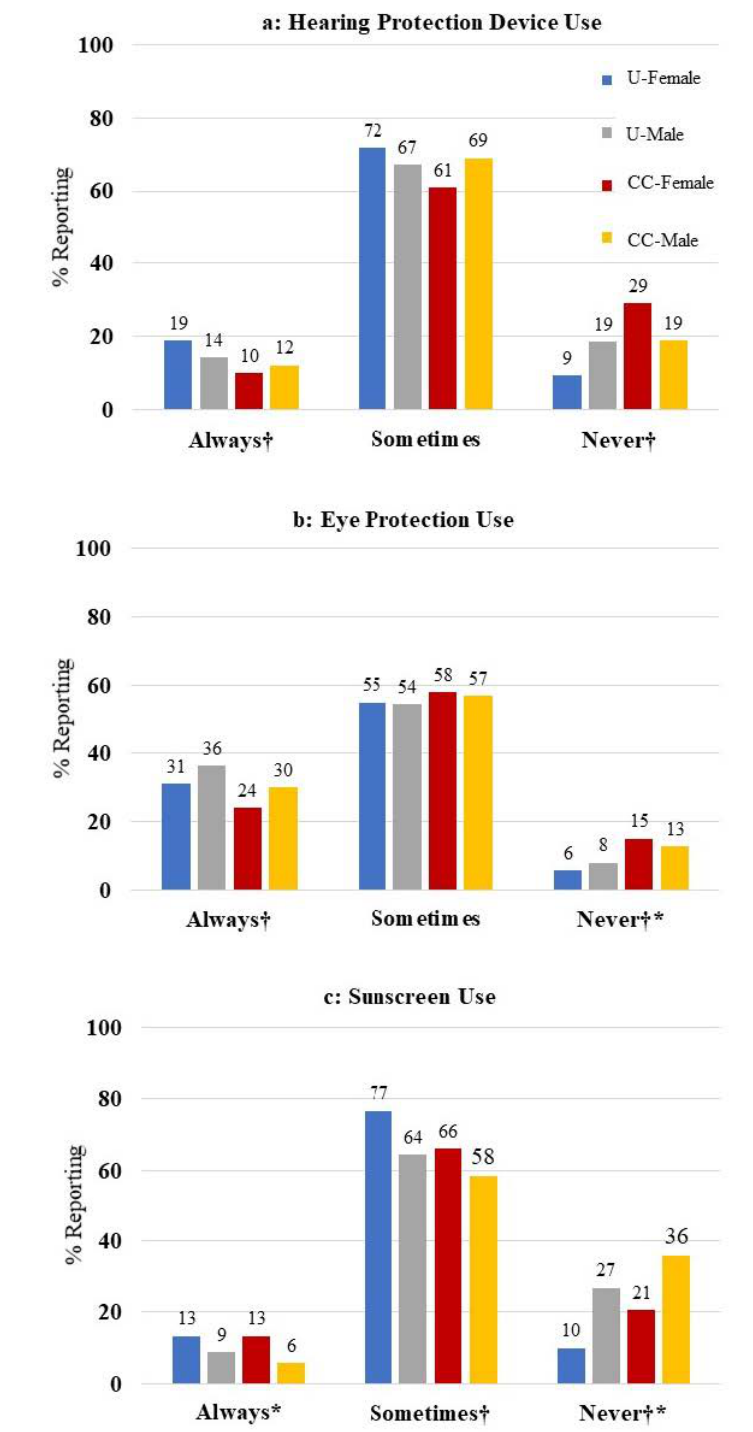
Figure 2. Proportion of participants reporting safety behaviors such as hearing protection device, eye protection, and sunscreen use when performing agricultural tasks. Note: U-Female = University female; U-Male = University male; CC-Female = Community College Female; CC-Male = Community College Male. * Indicates differences between male and female responses, using a 2 proportions Z-test ( p ≤ 0.05); † Indicates differences between university and community college responses, using a 2 proportions Z-test ( p ≤ 0.05).